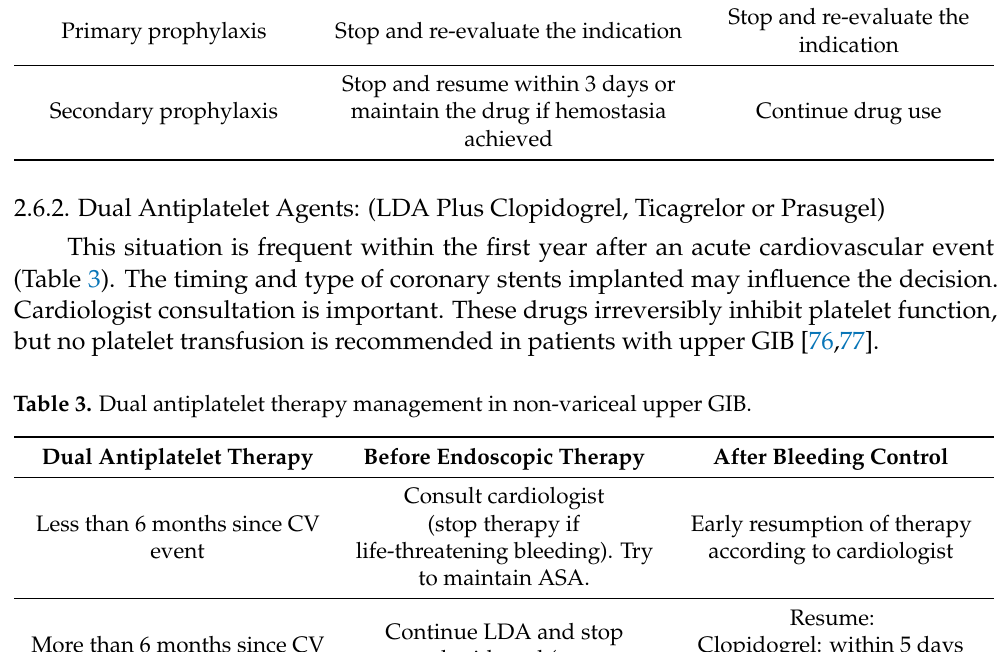
Table 2. Single antiplatelet agent management in non-variceal upper GIB. Single Antiplatelet Agent